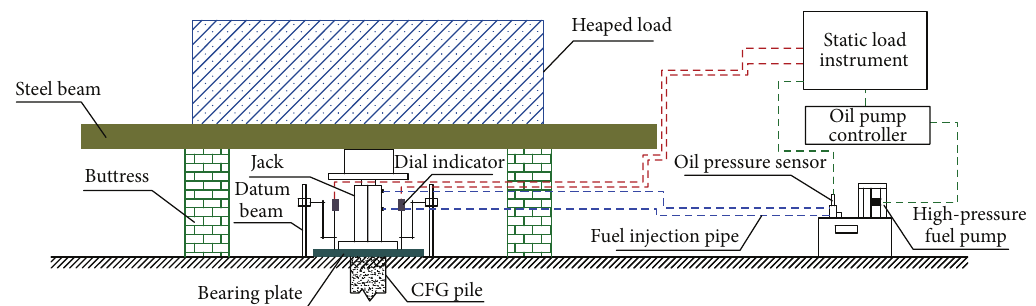
Figure 2: In situ diagrams in various construction stages.